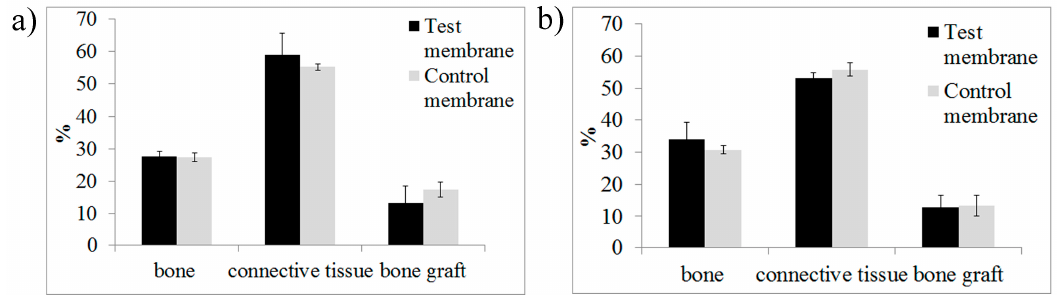
Figure 7. Percentage (%) distribution of the bone tissue, connective tissue, and residual bone grafts at ( a ) 4 and ( b ) 8 weeks.